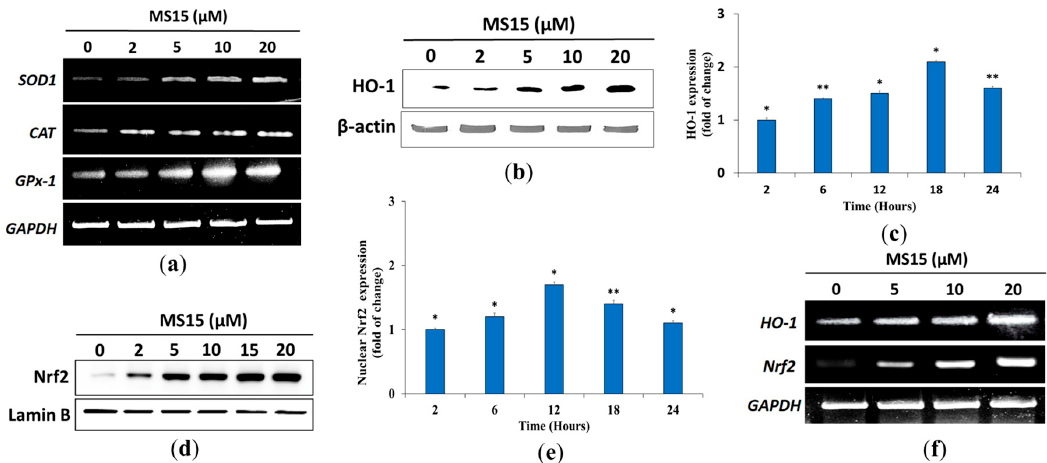
Figure 6. Effects of MS15 on the expression mRNA levels were checked on the detoxifying enzyme, primary and Phase II antioxidant in RAW 264.7 cells. RAW 264.7 cells with the required concentration of MS15 were pretreated for 24 h. ( a ) RT-PCR was used to test the mRNA expression of Phase II antioxidants, and primary antioxidant enzymes (GPx-1, CAT, SOD1) were assessed in a concentration reliant way. The expression of HO-1 was evaluated by Western blot analysis in ( b ) a concentration reliant and ( c ) time reliant (the fold of change) way. Impact of MS15 on Nrf2 activity, RAW264.7 cells with the required concentration of MS15 were pretreated for 24 h. Western blot analysis was used to calculate the nuclear translocation of Nrf2 in ( d ) a concentration reliant and ( e ) a time reliant (fold of change) way. ( f ) The mRNA of the detoxifying enzyme (HO-1) and Nrf2 were assessed by RT-PCR in a concentration reliant